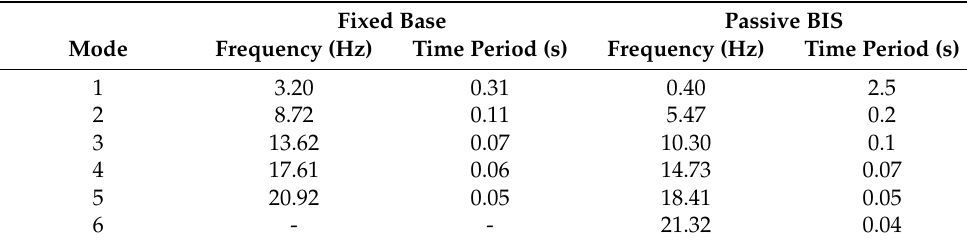
Table 3. Structure vibration